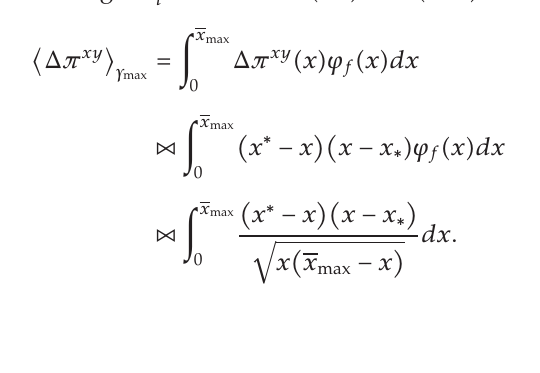
For instance, substituting Δ π xy